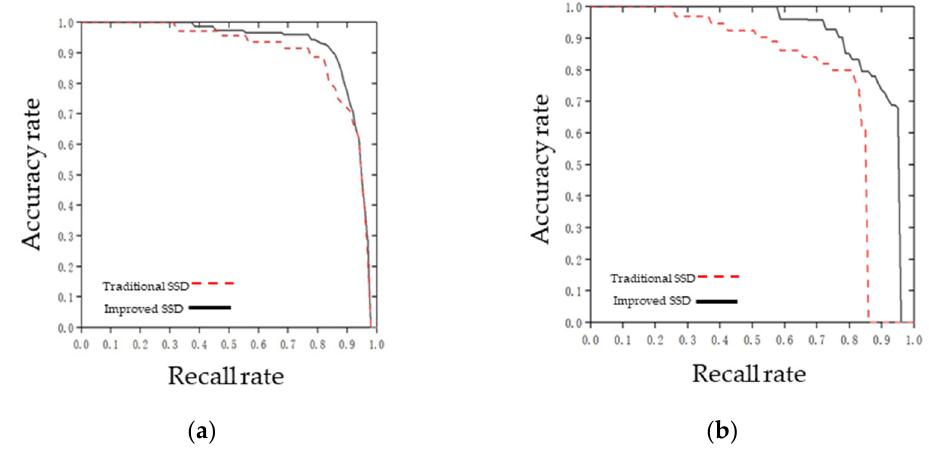
Figure 9. Comparison of accuracy–recall curves under two algorithms of breeding geese and goose egg: ( a ) breeding geese; ( b ) goose eggs. egg: ( a ) breeding geese; ( b ) goose eggs.